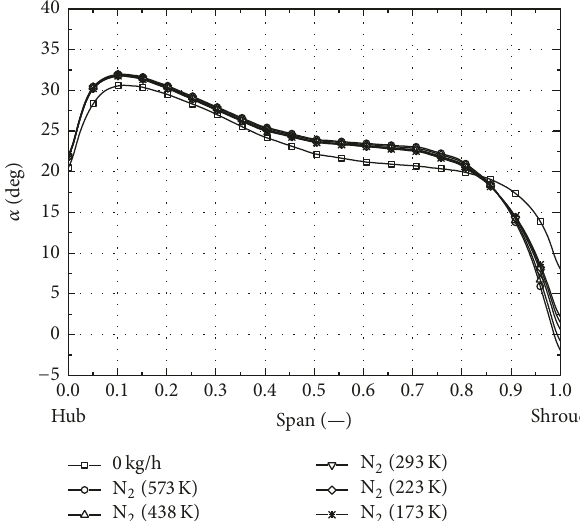
Figure 24: Flow angle in span direction of different temperatures.